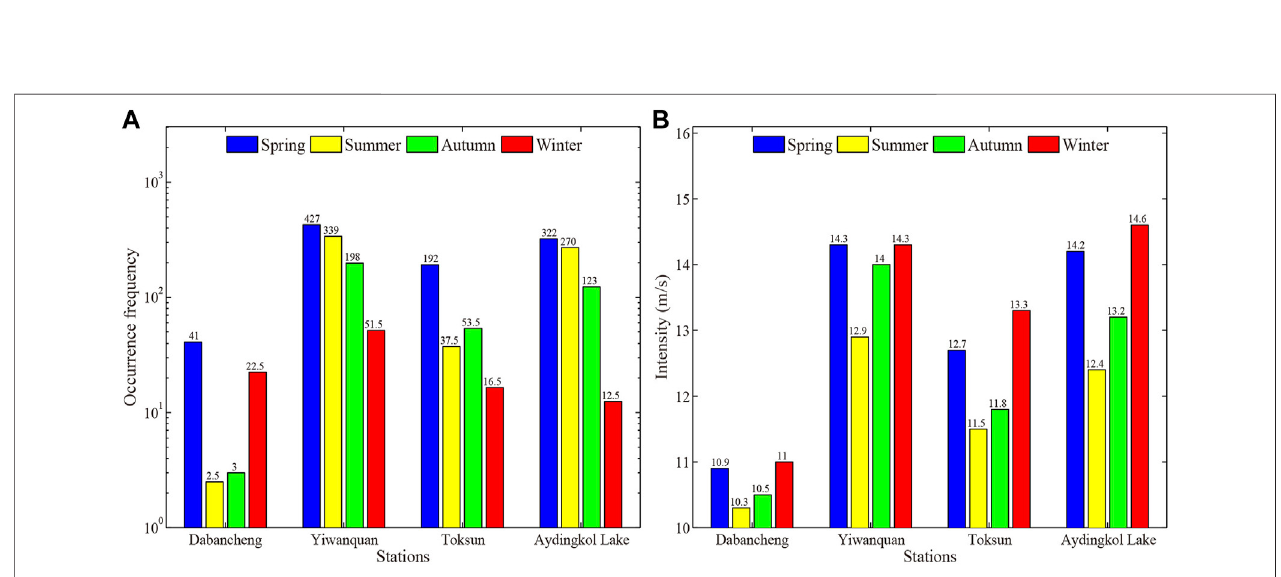
FIGURE 4 | Seasonal variations of HWHs (A) occurrence frequency and (B) intensity at the four stations in southern TGC.